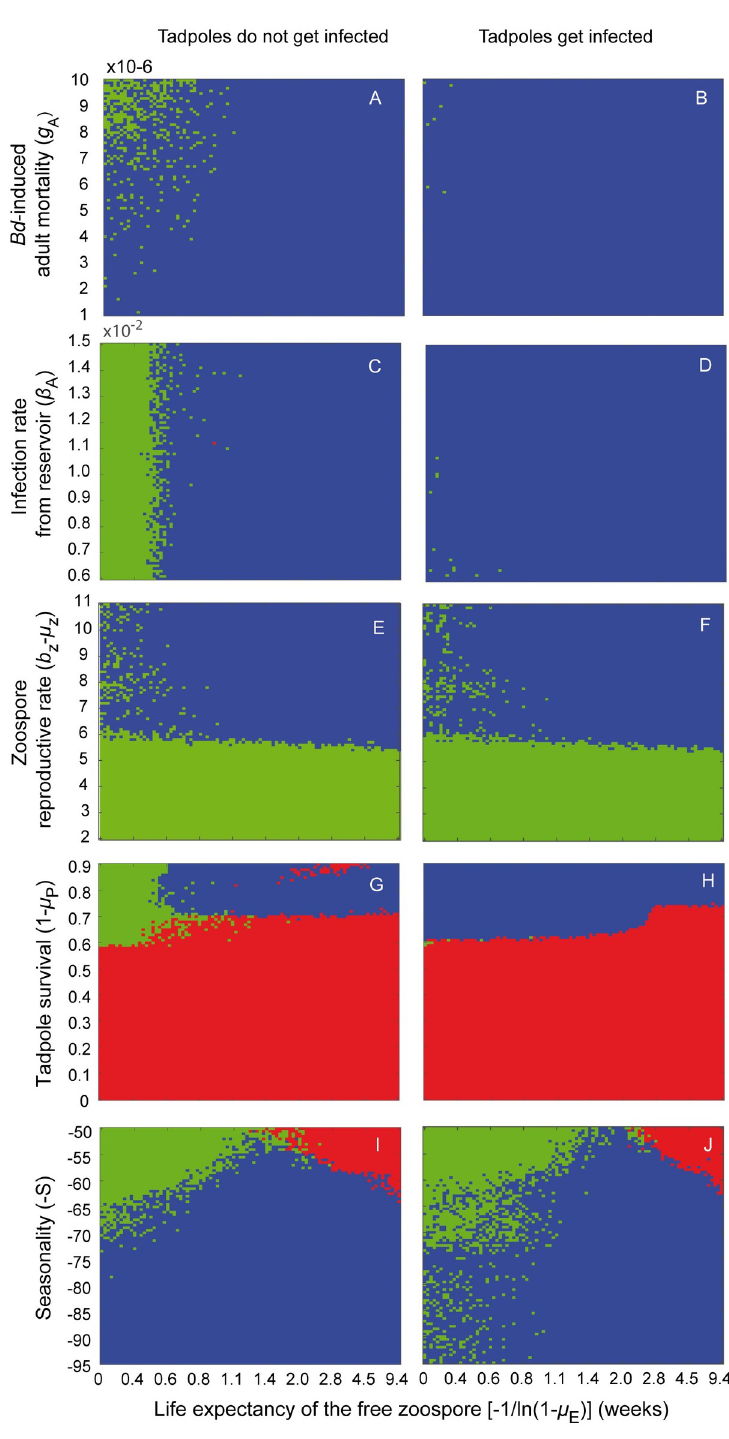
Fig 4. Infection outcomes expected for pairs of parameters. Each pixel represents a simulation of 2,000 weeks. Blue pixels represent combinations of parameters for which coexistence is the most likely outcome, green denotes pairs for which Bd is most likely to fail in establishing and red denotes pairs for which Bd is more likely to extirpate the toad population. In the left panel (A,C,E,G,I), tadpoles do not get infected. In the right panel (B,D,F,H,J), tadpoles get infected but do not develop lethal chytridiomycosis. Population parameters fixed are described in Table 1 in S1 Appendix.